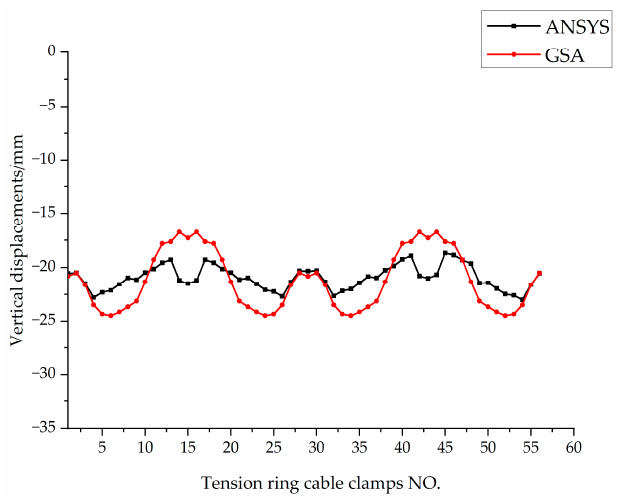
Figure 10. Comparison curve of vertical displacement of typical tension ring nodes (mm).